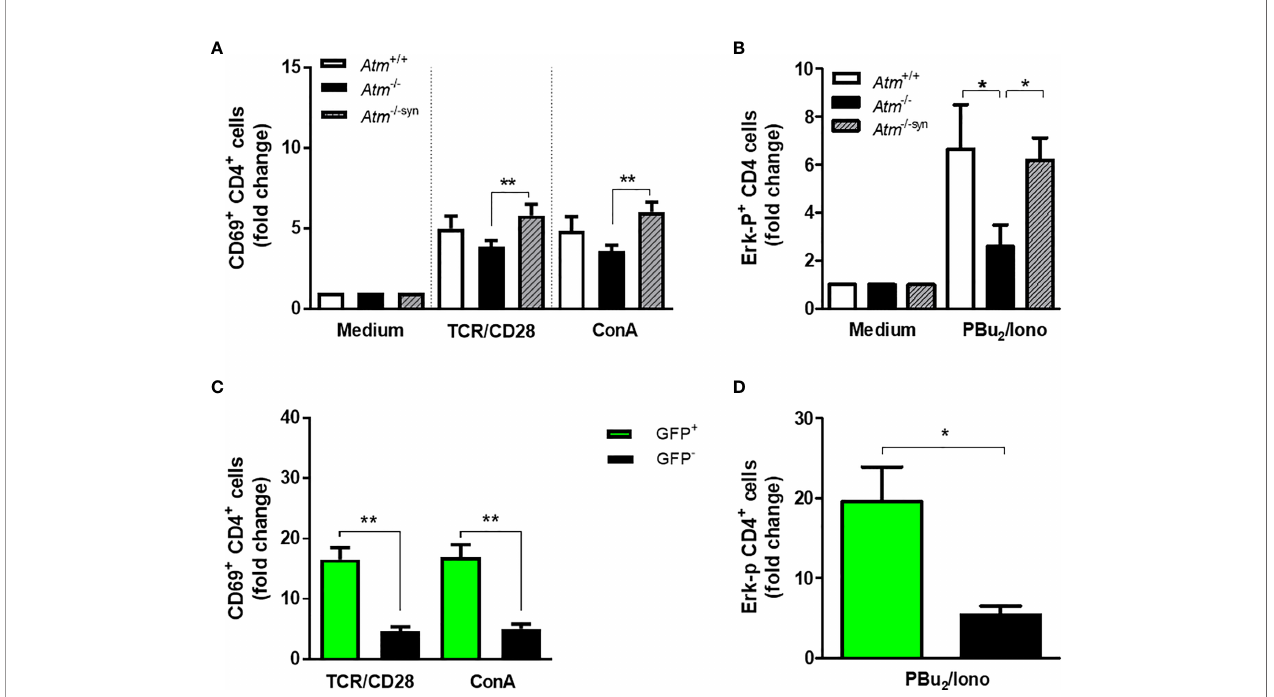
FIGURE 4 | TCR-dependent T-cell activation and Expression of the phosphorylated (p)-Erk protein in Atm -de fi cient mice after syngeneic HSCT. (A) Flow cytometric analysis of T-cell activation in CD4 + splenocytes from Atm +/+ (n = 7), Atm -/- (n = 7) and syngeneic transplanted Atm -/- mice (n = 9, Atm -/-syn ) 12 weeks post HSCT using CD69 as activation marker. The cells were stimulated either via TCR/CD28 or via ConA for 4 h in vitro and the data were normalized to the medium control. (B) Expression of the phosphorylated (p)-Erk protein in stimulated CD4 + splenocytes from Atm +/+ (n = 10), Atm -/- (n = 8) and Atm -/-syn (n = 9) 12 weeks after HSCT measured by fl ow cytometry. The cells were either stimulated via TCR/CD28 for 5 min and PBu 2 /Iono for 15 min in vitro . The data were normalized to the unstimulated medium control. (C) T-cell activation in GFP + and GFP - CD4 + T-cells from Atm -/-syn mice stimulated either directly via a CD3 and a CD28 or nonspeci fi cally by ConA for 4 h 12 weeks after HSCT. (D) Expression of the signaling protein Erk in GFP + and GFP - CD4 + T-cells from Atm -/-syn stimulated via PBu 2 /Iono. Data are presented as mean ± SEM. * p < 0.05, ** p < 0.01. ConA, Concanavalin A; GFP, green fl uorescent protein; HSCT, hematopoietic stem cell transplantation; TCR, T cell